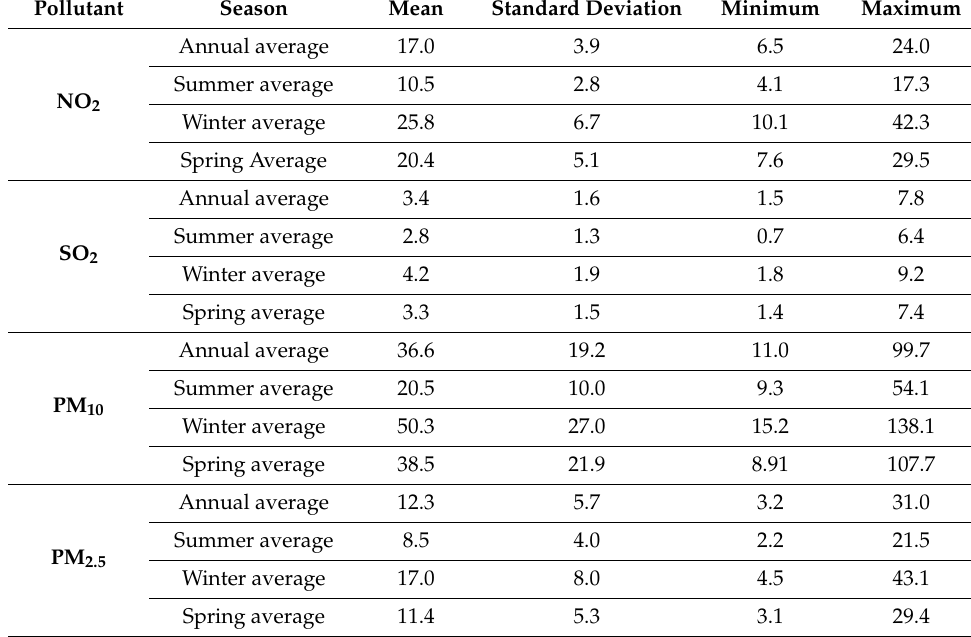
Table 1. Adjusted annual average annual and seasonal nitrogen dioxide (NO 2 ), sulphur dioxide (SO 2 ), PM 10 , and PM 2.5 concentrations ( µ g / m 3